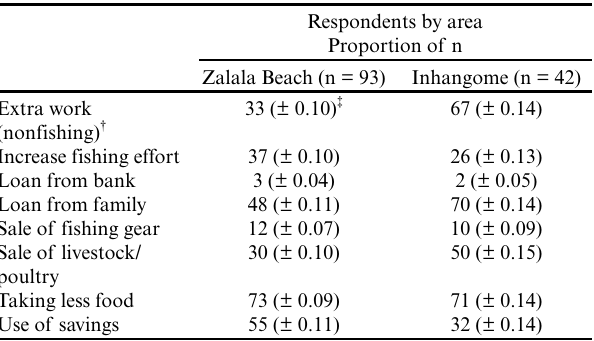
Table 2 . Adaptive strategies in response to livelihood stress across the study areas. Values indicate the percentage of total survey respondents in each community who identified using each adaptive strategy during the previous 12